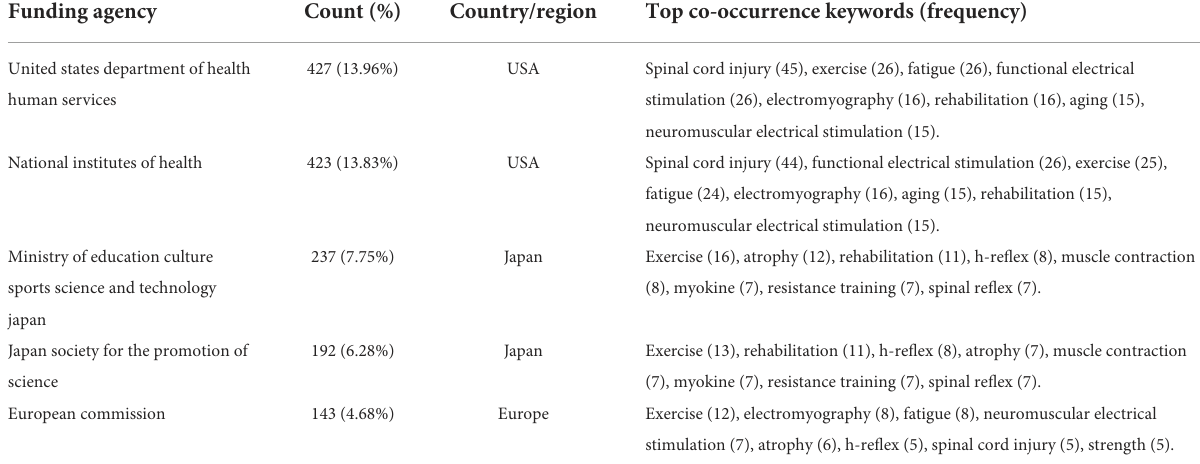
TABLE 6 The top 5 funding agencies and co-occurrence keywords from publications. Funding